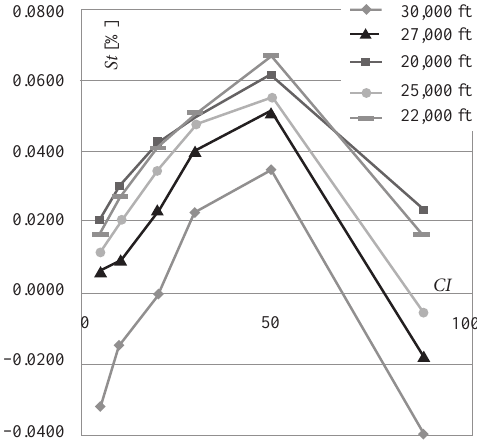
Fig. 4. Percentage of saving for en route flight profile total